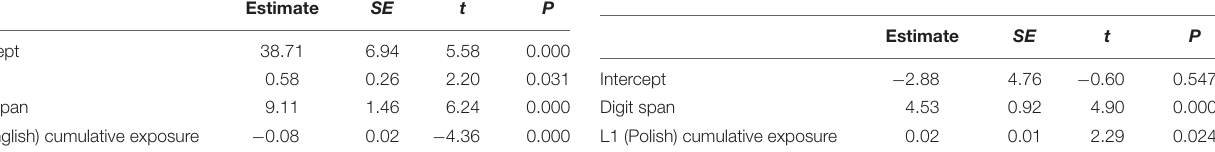
TABLE 6 | The best regression model predicting the phonological processing in the bilingual group.